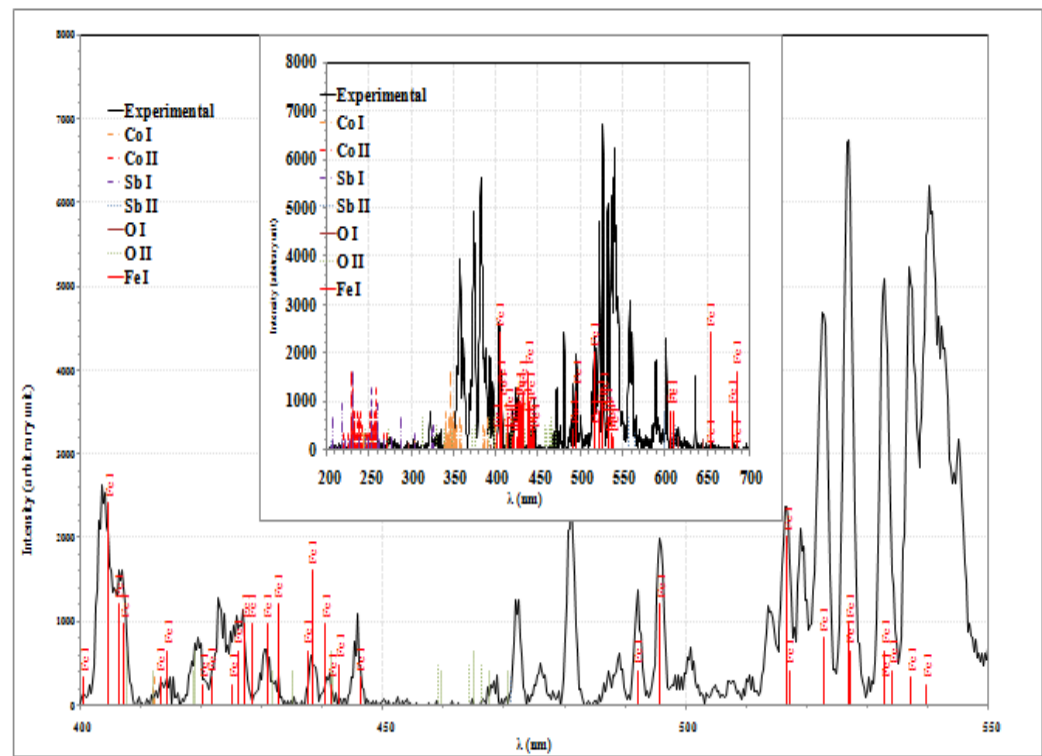
Fig. 7: Emission spectra for FeCoSb alloy exploding